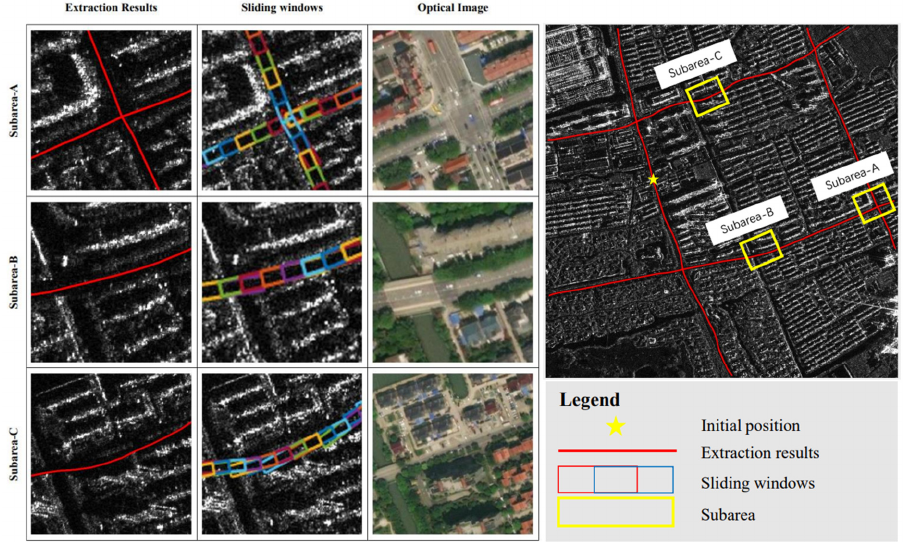
Figure 10. Demonstration of the road extraction in Area-I, where subarea-A and subarea-B are typically correct extractions while subarea-C is an extraction that is not exactly